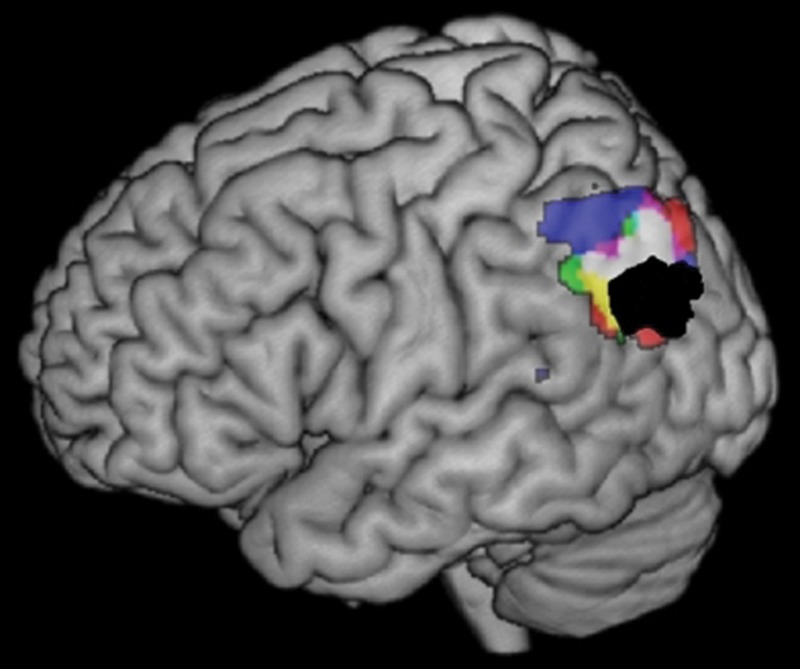
The overlap between the DMN (black) and the AG-related tasks (automatic semantics [red], episodic retrieval [blue], numerical fact retrieval [green], and sentence-level processing [purple]). Meta-analysis results were thresholded at FDR correction of P < 0.05 and a minimum cluster size of 100 mm³.